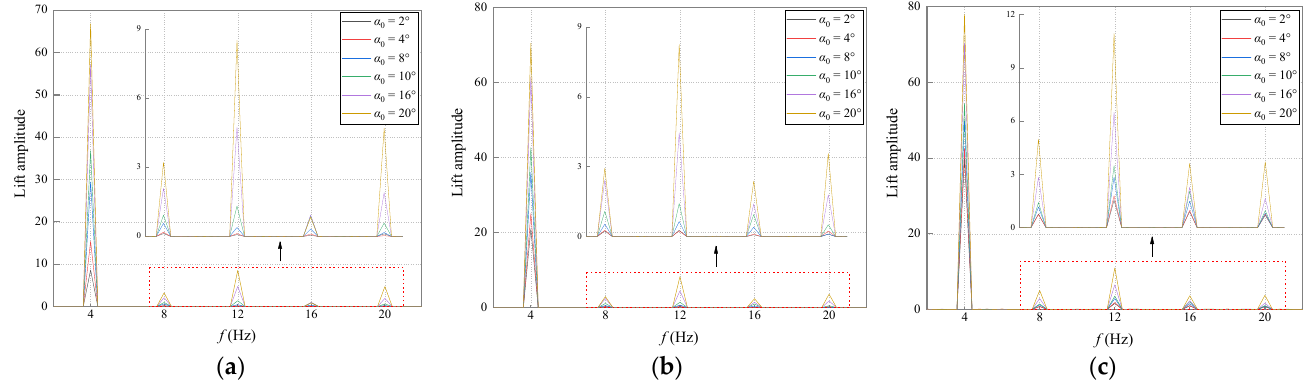
Figure 12. Aerodynamic lift spectrum under different coupled amplitude. ( a ) Heaving amplitude h 0